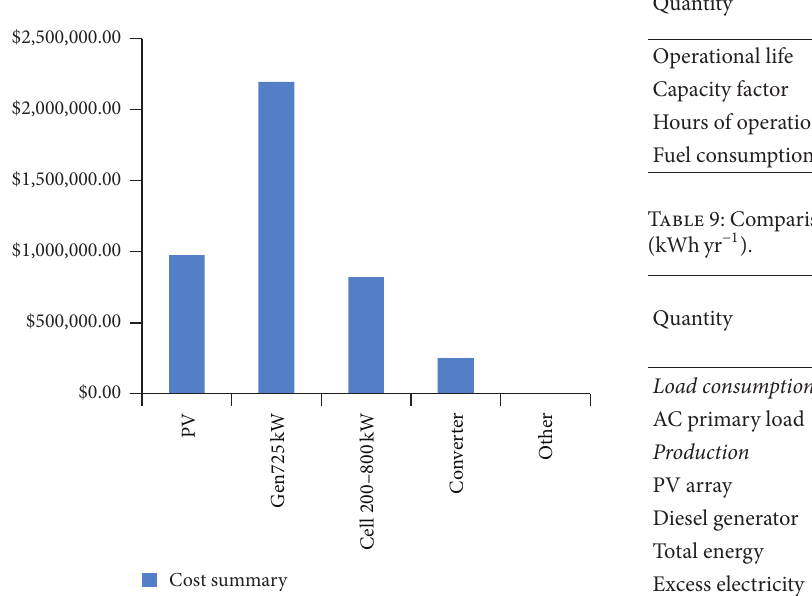
Figure 7: Cash flow analysis of NPC of optimized hybrid energy system [7].